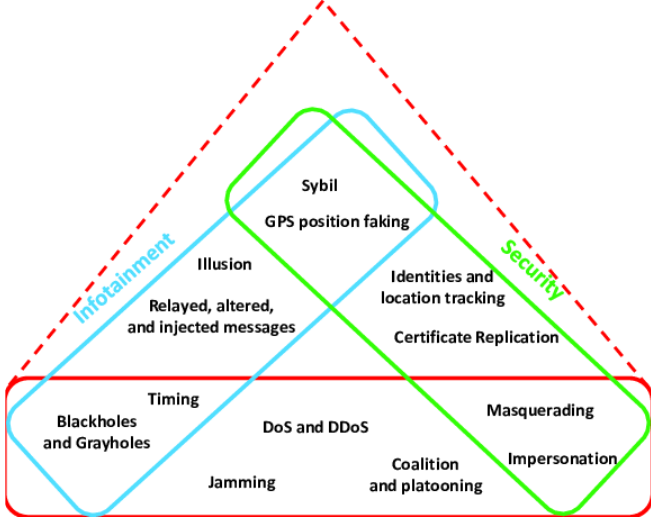
Figure 22. Taxonomy of attacks with respect to security and infotainment applications.